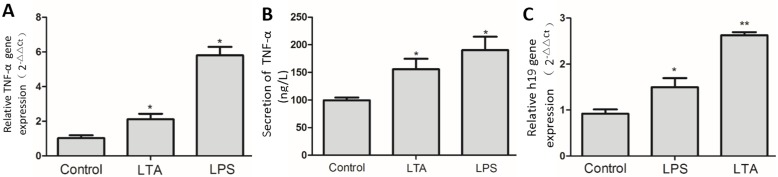
Expression of H19 in MAC-T cells with or without LPS or LTA treatment.(A and B) An inflammatory epithelial cell model was established by LPS or LTA stimulation in vitro. TNF-α was used as an indicator of MAC-T cell inflammatory responding to stimulus. TNF-α mRNA expression in treated cells was analyzed by RT-qPCR (A), and TNF-α protein secretion in the medium was measured with an ELISA kit (B). (C) Expression of H19 in MAC-T cells was analyzed by RT-qPCR. Untreated MAC-T cells were used as a control. GAPDH was used as an internal control. ∗p < 0.05, ∗∗p < 0.01 vs control.